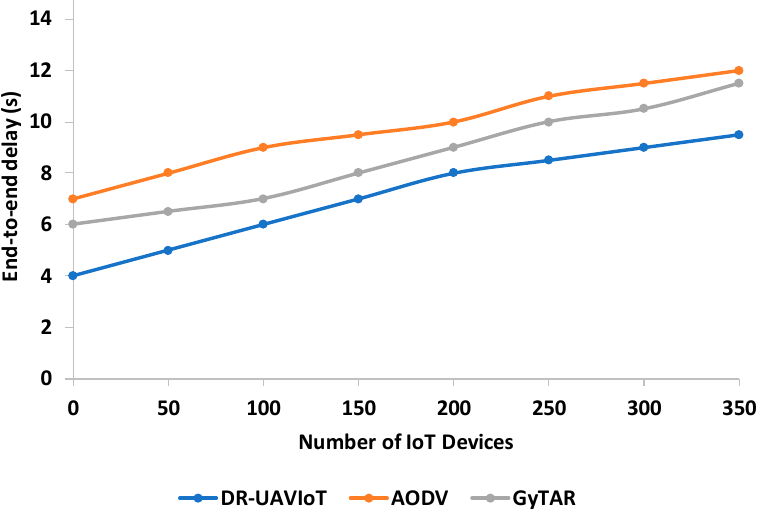
Figure 8. End-to-End Delay in the Presence of Different Numbers of IoT Devices.